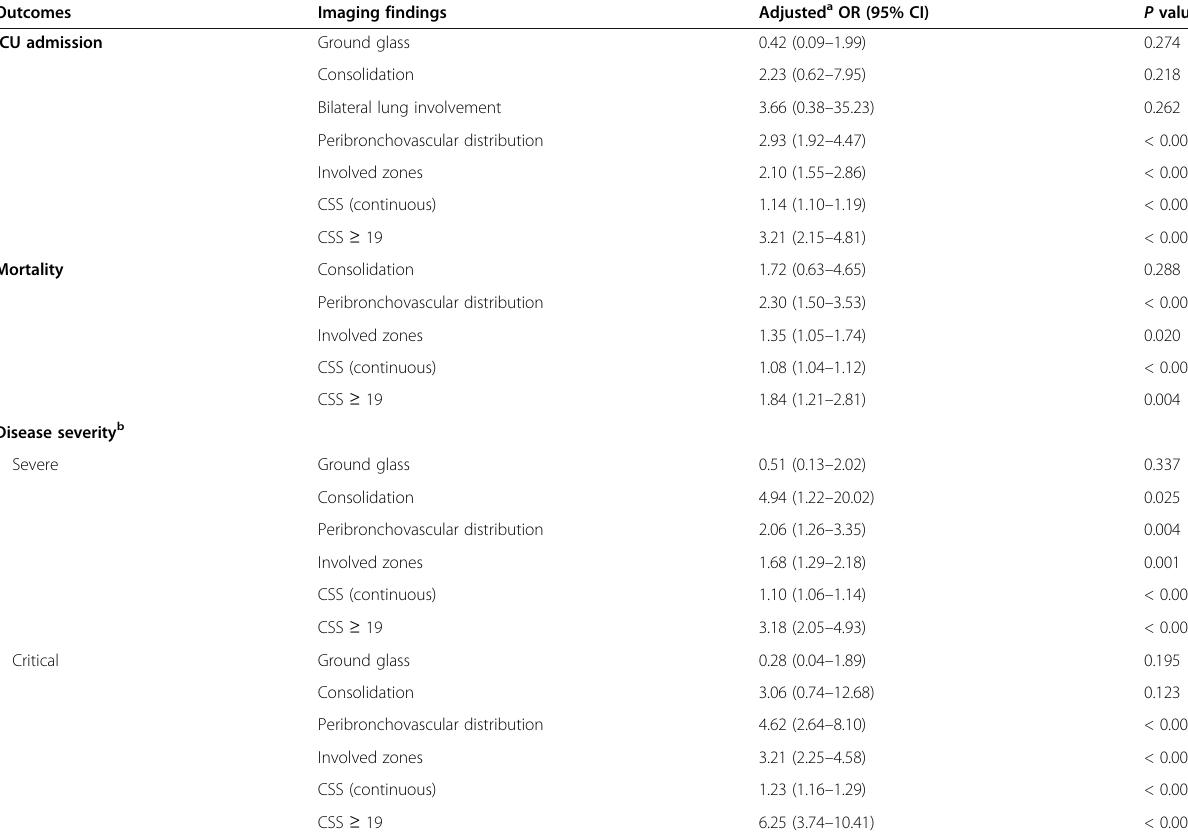
Table 5 Association between imaging findings and adverse clinical outcomes of COVID-19